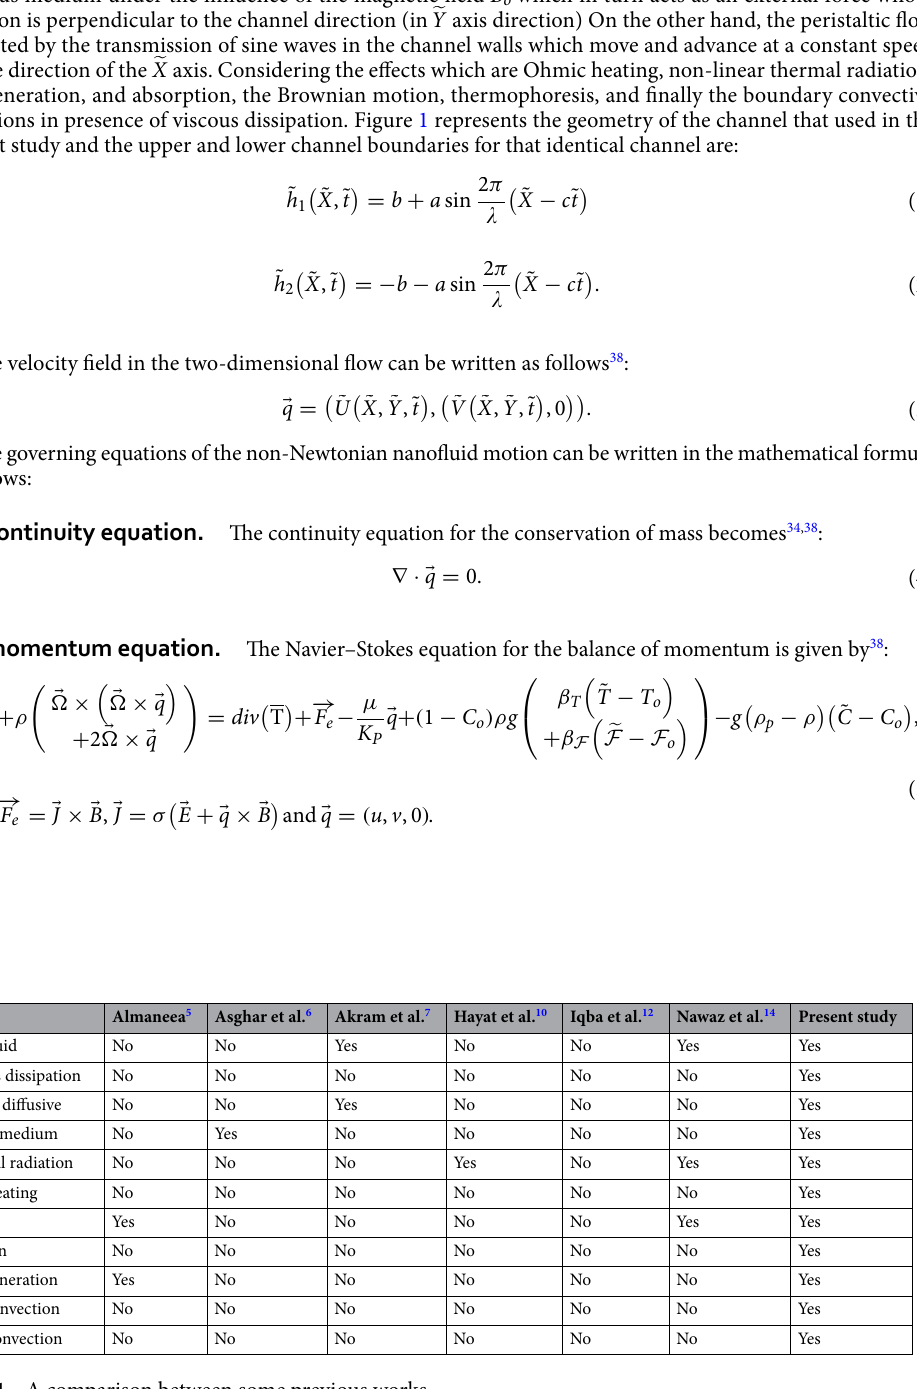
Table 1. A comparison between some previous